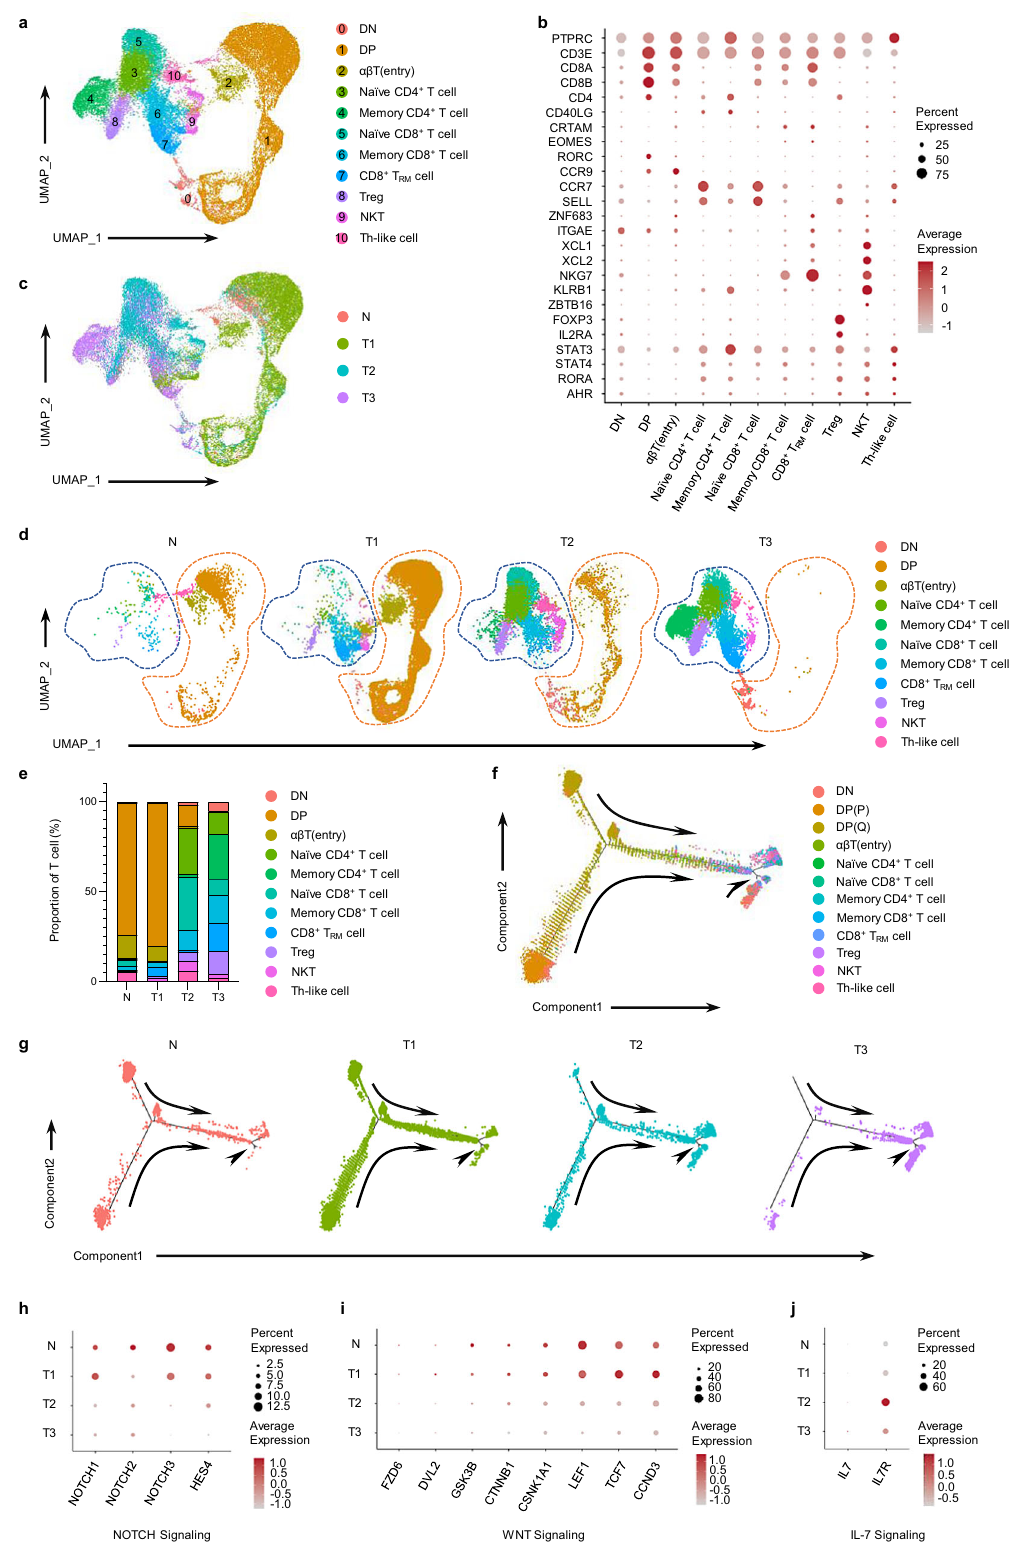
system and WHO classi fi cation were not signi fi cant ( P =0.1698, P =0.2912) (Supplementary Fig. 15b, c). Collectively, based on our fi ndings, we proposed a tripartite framework to explain the origin of tumor cells and their impact on T-cell development in the tumor microenvironment of human TETs (Fig.